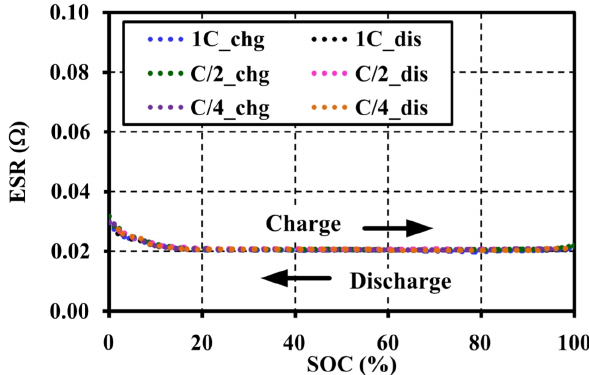
Figure 7. Effects of pulse current amplitudes on the OCV characteristic at 20 °C with 60 min resting: ( a ) under the charge test; and ( b ) under the discharge test.